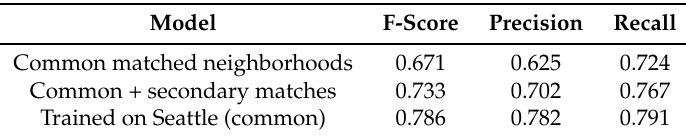
Table 5. F-score, precision and recall values for two random forest models trained on listings from Washington, DC, and tested on listings from Seattle, WA (the first two rows). The last row shows the results of a model trained and tested on listings from Seattle,